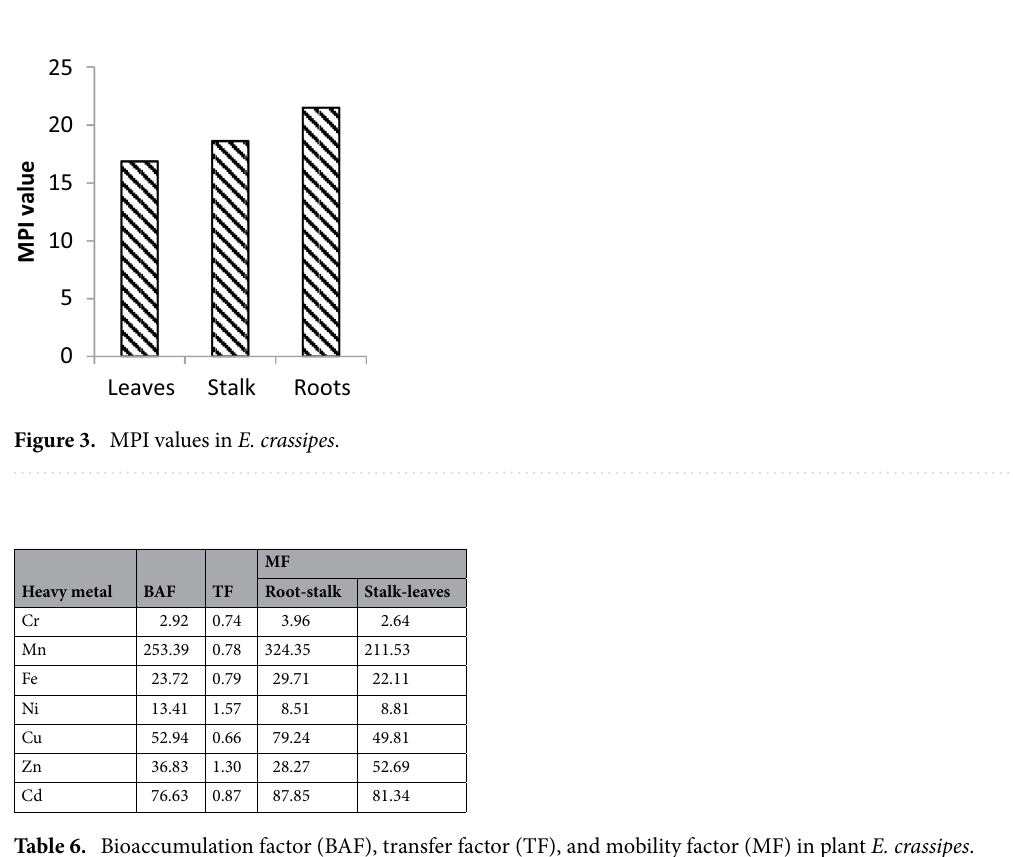
Table 6. Bioaccumulation factor (BAF), transfer factor (TF), and mobility factor (MF) in plant E. crassipes